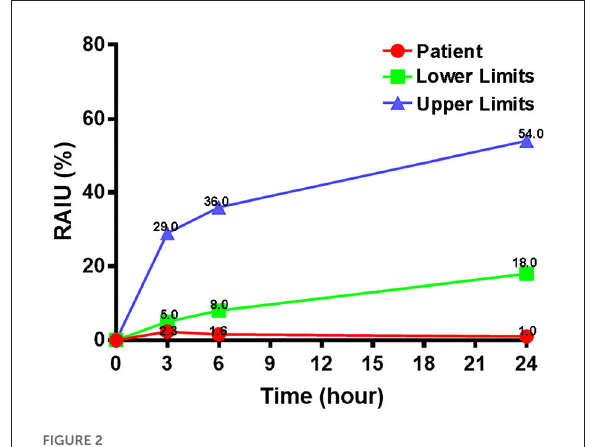
FIGURE2 Thyroid radioactive iodine